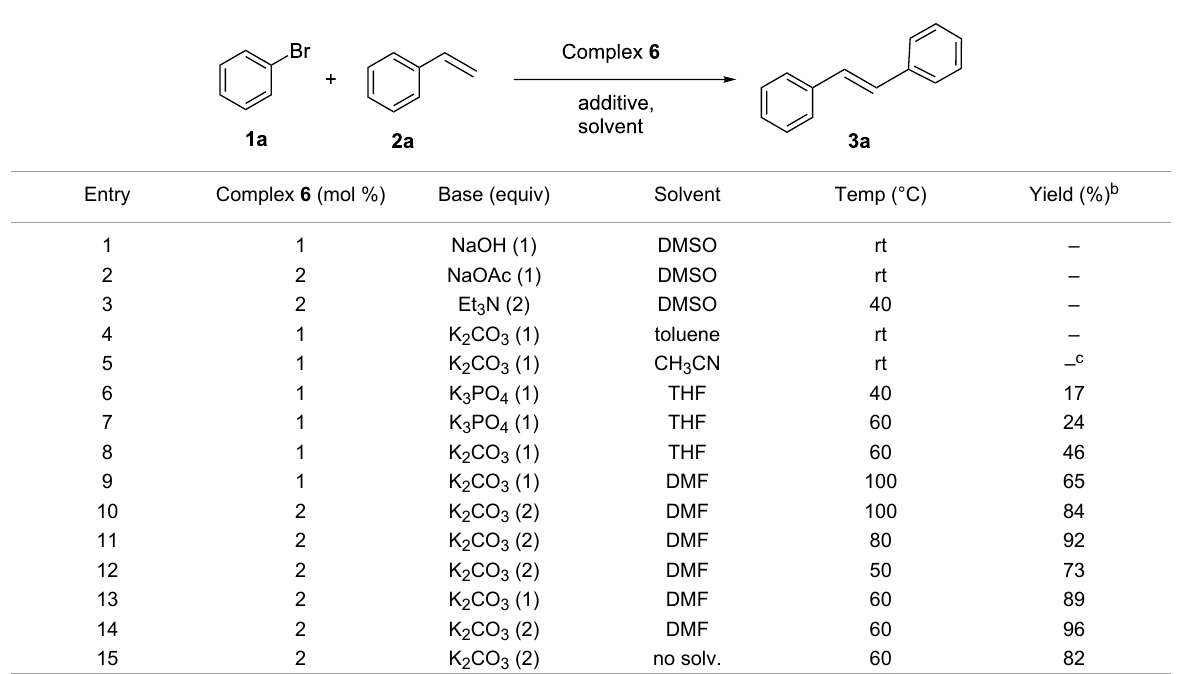
Table 1: Palladium complex ( 6 ) catalyzed Heck reaction of bromobenzene and styrene: Optimization of reaction conditions.